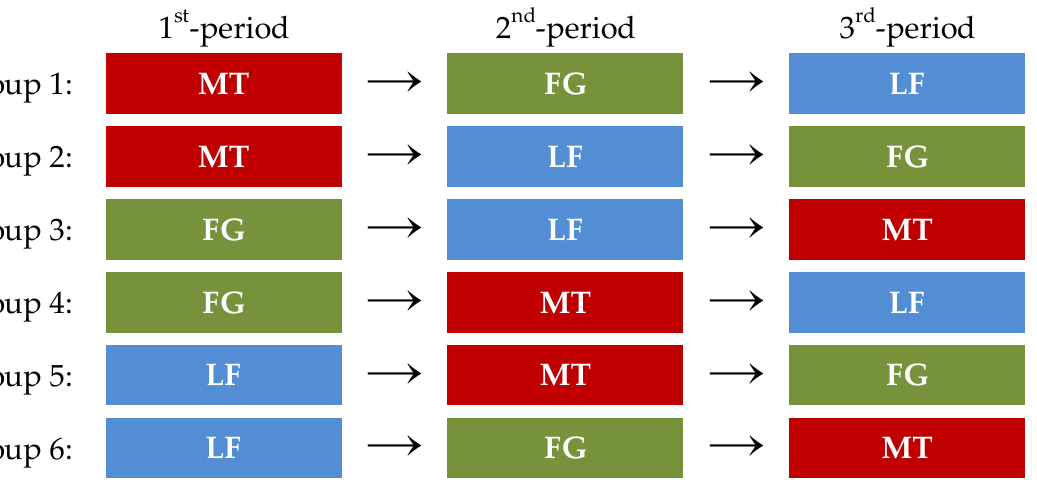
Figure 1. Administration sequence of the minitablets (MT), fine granules (FG), and liquid formula- tions (LF).